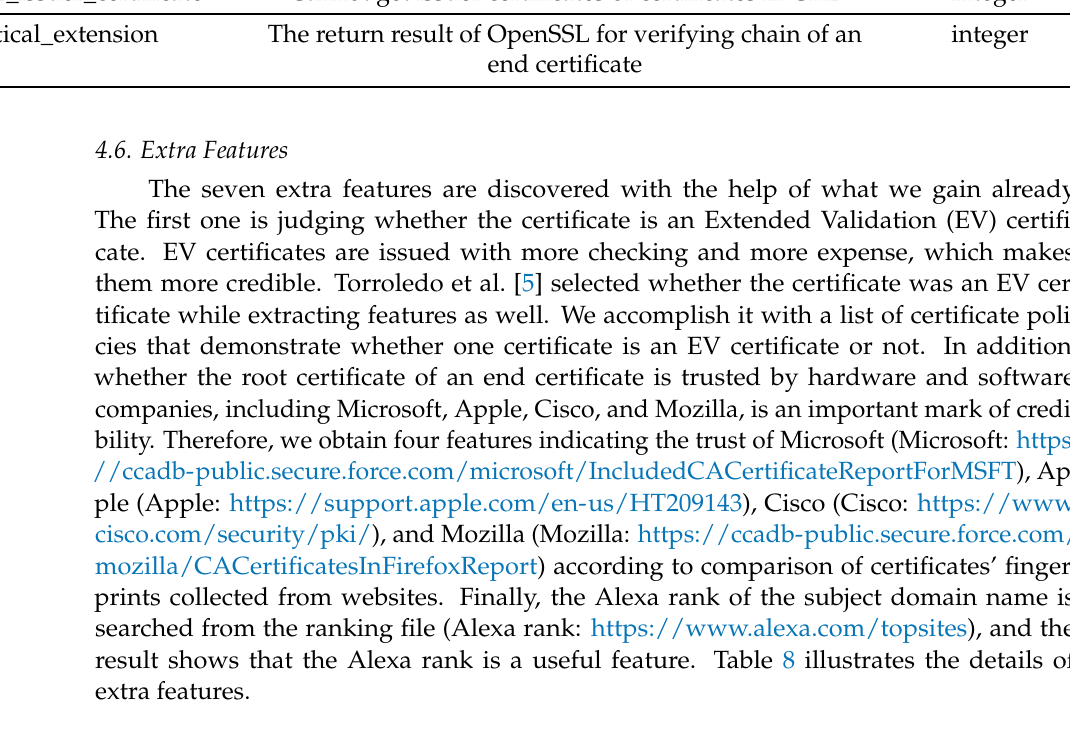
Table 8. Details of features from extra